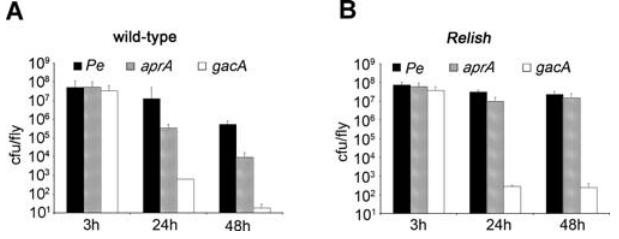
Figure 3. Bacterial Persistence in Wild-Type and Rel Flies (A) Bacterial persistence was measured in live wild-type flies by plating appropriate dilutions of homogenates of five surface-sterilized adults on LB medium containing rifampicin. The flies had been previously orally infected with rif R strains of wild-type P. entomophila and its aprA and gacA derivatives. AprA mutants persisted less than wild-type P. entomophila but better than the gacA mutant. (B) Persistence of wild-type P. entomophila aprA and gacA mutants in live Rel flies. AprA mutant bacteria persisted at a level similar to wild-type bacteria in Rel mutant flies whereas gacA bacterial levels decreased with